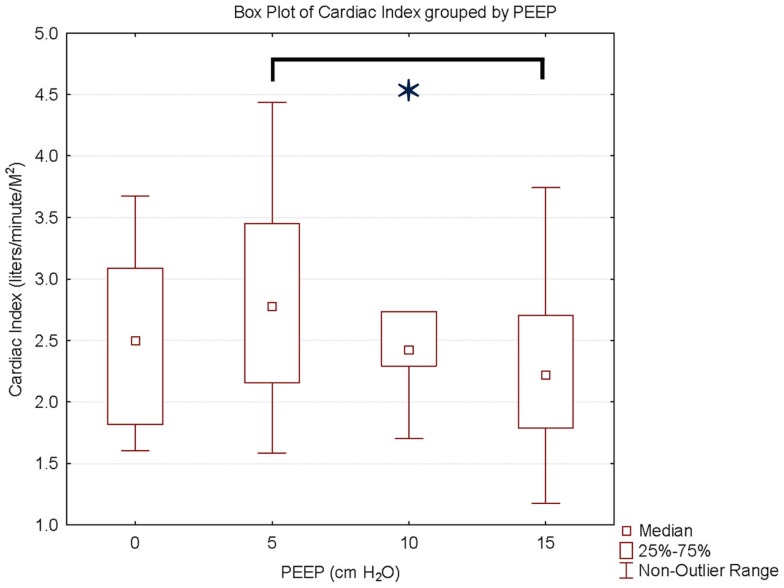
Cardiac index and PEEP. Data are presented as median, inter-quartile, and non-outlier range. There is a statistically significant decrease in cardiac index at PEEP of 15 cm H2O compared to PEEP 5 cm H2O.